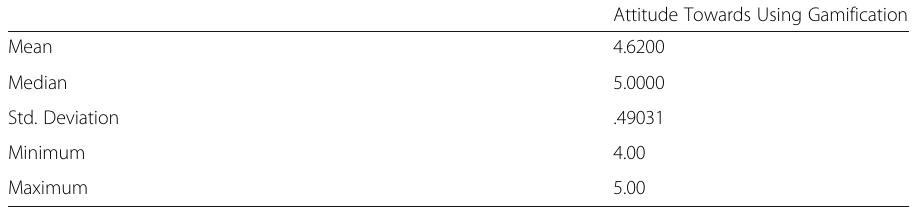
Table 11 Analysis for attitude towards using